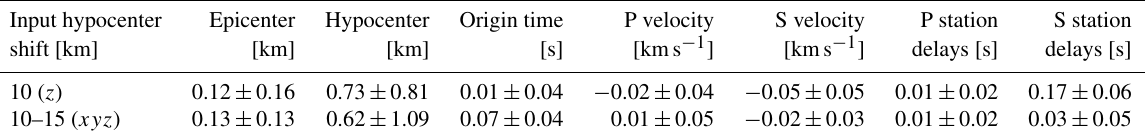
Table 2. The results of the systematic and pseudorandom hypocenter shift tests for the MPS velocity model, given as the average and standard deviation of differences between the values obtained after another inversion and the final parameter values. The velocity values are calculated only for the well-sampled layers between 0 and 38km. The statistics for the epicenter and hypocenter values were calculated from the lengths of vector